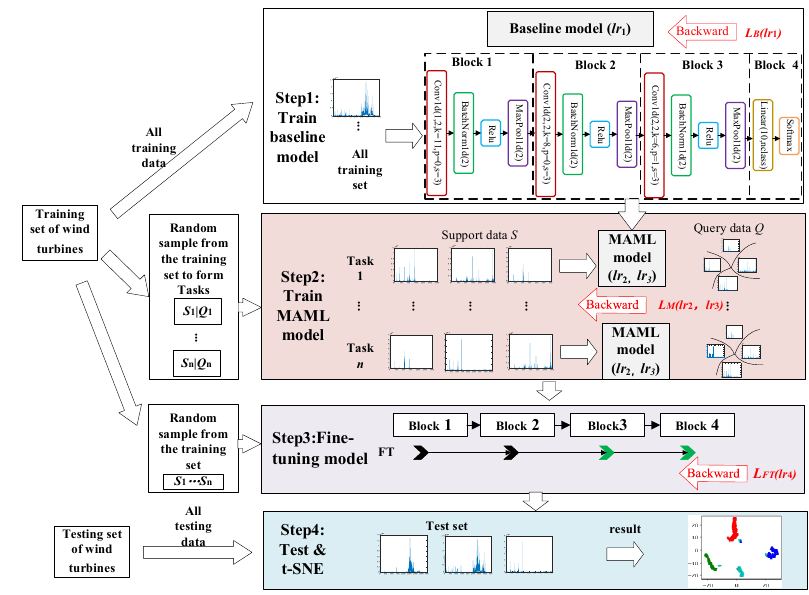
Figure 4. The proposed model (MAMB) for few-shot learning of wind turbines. The classifier model contained three convolution layers, three BatchNorm1d, three MaxPool1d, and one fully connected layer. The number of neurons in each layer is marked in Figure 4. The activation functions of all layers were rectified linear units (Relu), except for the last layer where the activation function was Softmax. All the data went through the fast Fourier transform, and then it was fed into the